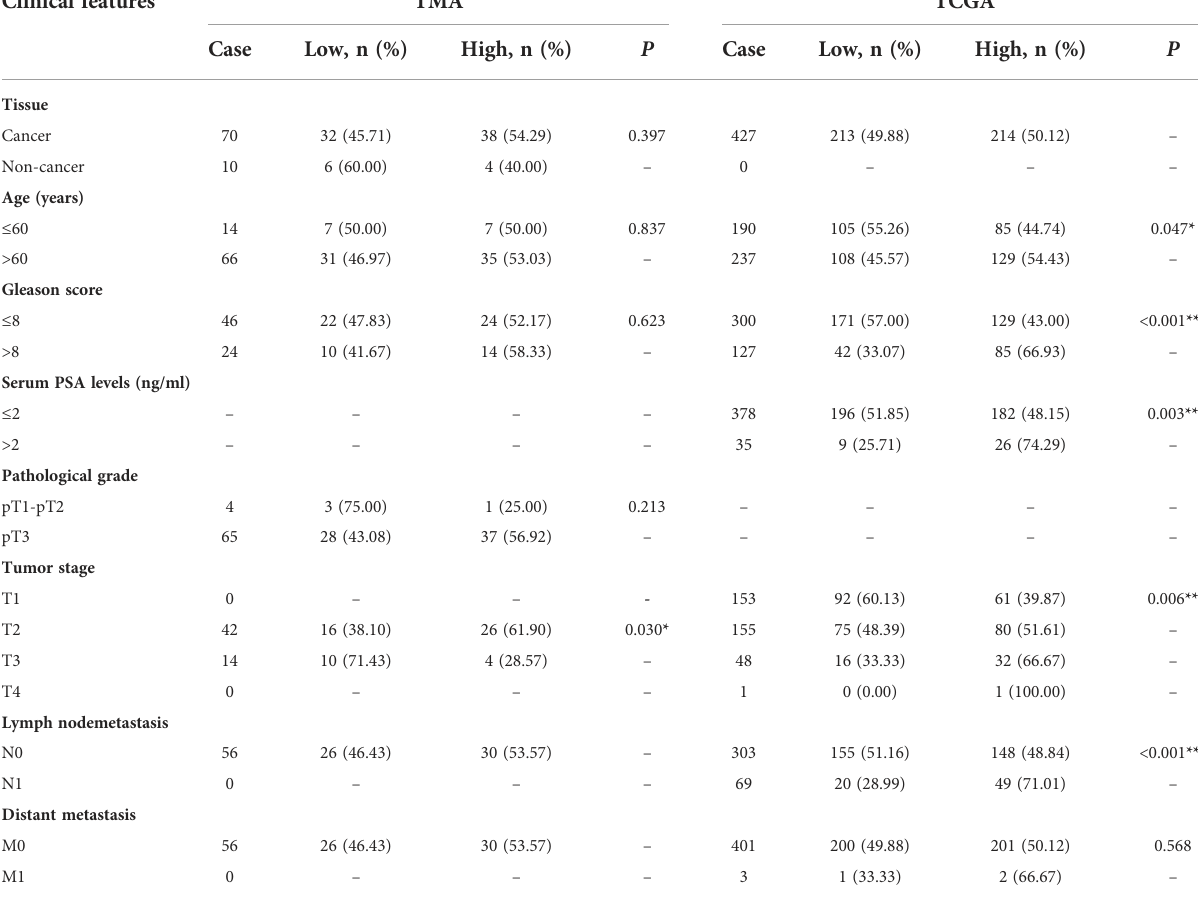
TABLE 2 Correlation of FCGR3A expression with clinicopathological features in PCa patients. Clinical features